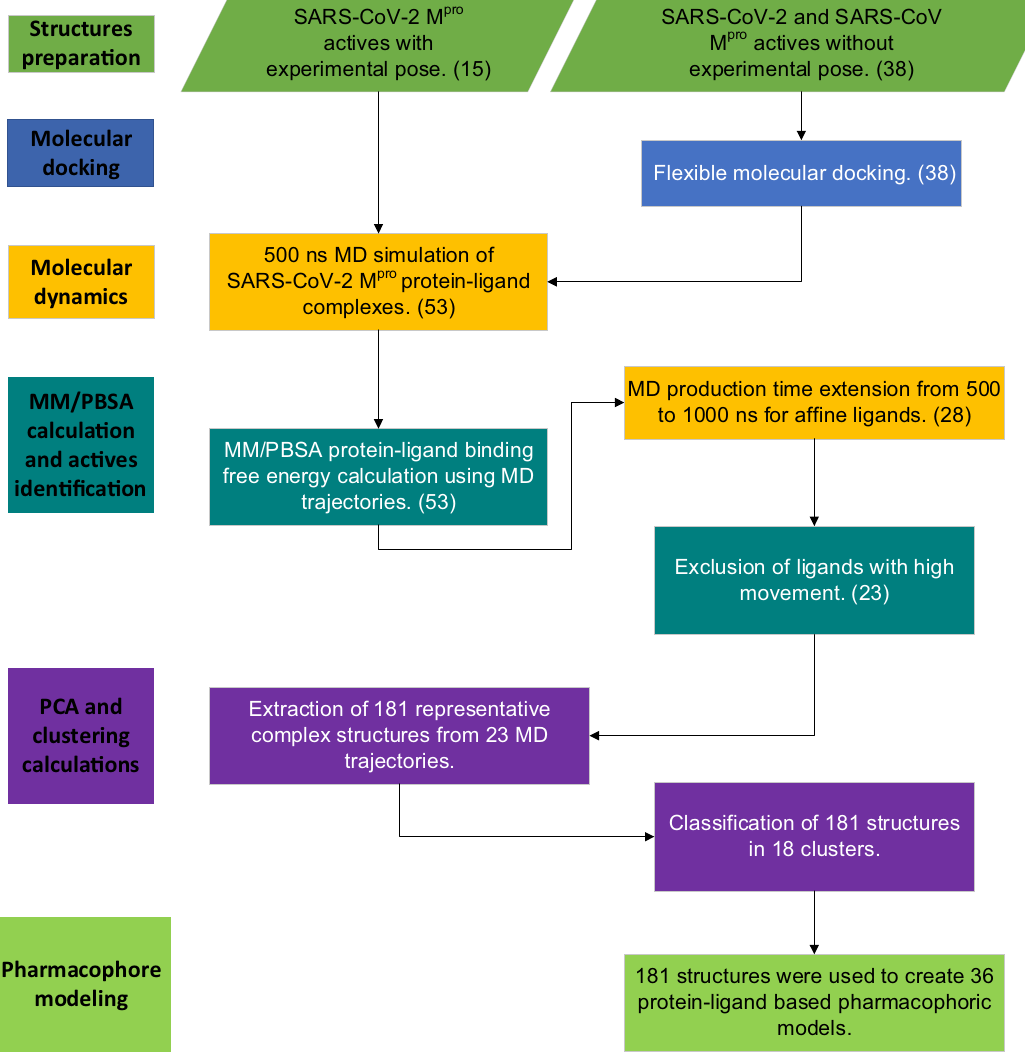
Figure 2. Summary of the methods to generate pharmacophore models for SARS-CoV-2 M pro . We collected 15 inhibitors with protein–ligand crystal available and 38 inhibitors with protein–ligand crystal unavailable. These 38 inhibitors went through a molecular docking process to predict ligand poses on the active site. The 38 predicted poses and the 15 experimental poses were taken to perform a MD simulation with 500 ns production time. The MD trajectories were used for MM/PBSA free energy calculations and 28 systems with protein–ligand binding free energy less than − 100 kJ/mol were identified and the respective ligands were considered as possible actives. The MD production time of these 28 systems was extended to 1000 ns. Ligands showing prominent movement on the active site were excluded resulting in 23 actives. The 23 MD trajectories were used for a PCA and clustering process in order to extract representative conformations of each ligand on the active site. Finally, the conformations were employed to create protein–ligand-based pharmacophore